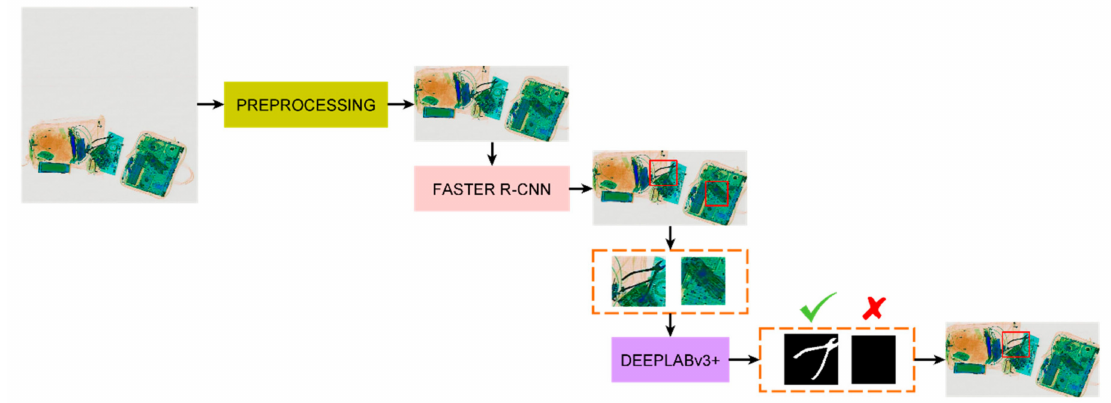
Figure 7. Full detection